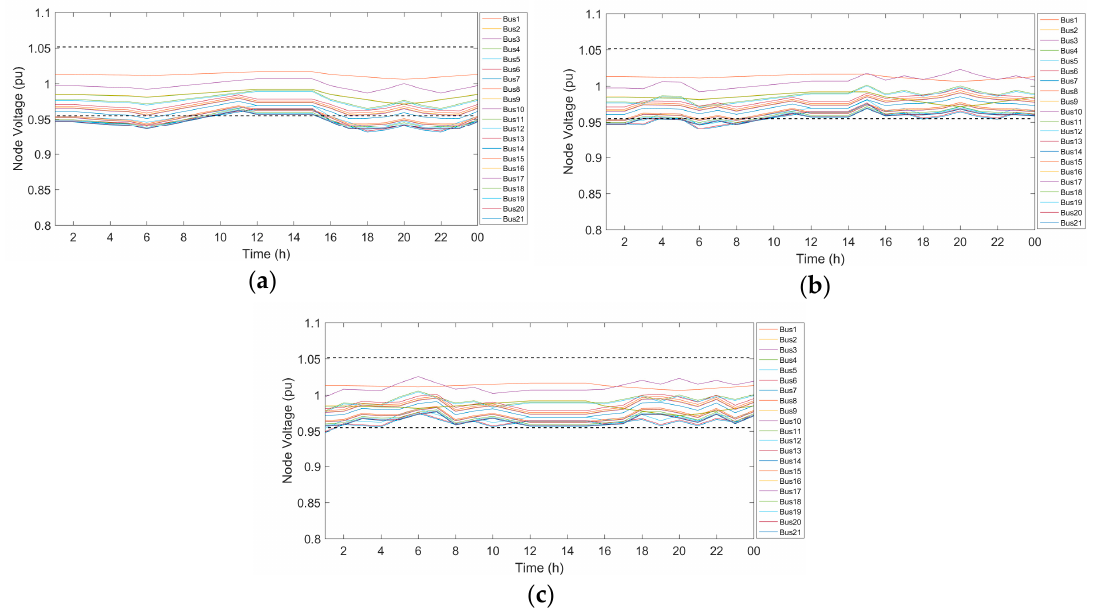
Figure 5. Node voltages of solution A for all tap position constraints ( 𝑔 (cid:3002) – 𝑔 (cid:3004) ). ( a ) Node voltages (equality constraint of 𝑔 (cid:3002) ); ( b ) node voltages (equality constraint of 𝑔 (cid:3003) ); ( c ) node voltages (equality constraint of 𝑔 (cid:3004) ).